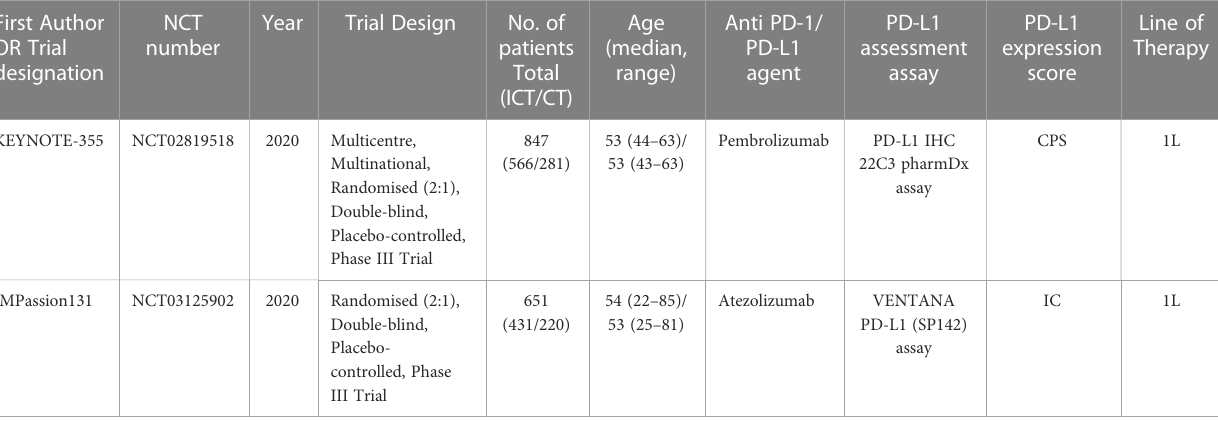
Progression-free survival was assessed using 1-year and overall PFS outcomes. One-year PFS event rates for PD-L1 expression cohorts were available in eight studies (n=1967). Pooled outcome indicated a signi fi cant 1-year PFS advantage for patients with PD- L1 expression (OR 1.39 [95%CI, 1.04-1.85], p=0.02; I 2 = 0%) (Figure 3A). There was no heterogeneity (Chi² = 4.85, df = 8 (P = 0.77); I² = 0%) and publication bias observed for this outcome as shown in Figure 3D. A direct comparison of overall PFS in these cohorts was available in 5 studies. Extracted hazard ratios were pooled which showed no difference between the cohorts (HR 0.88